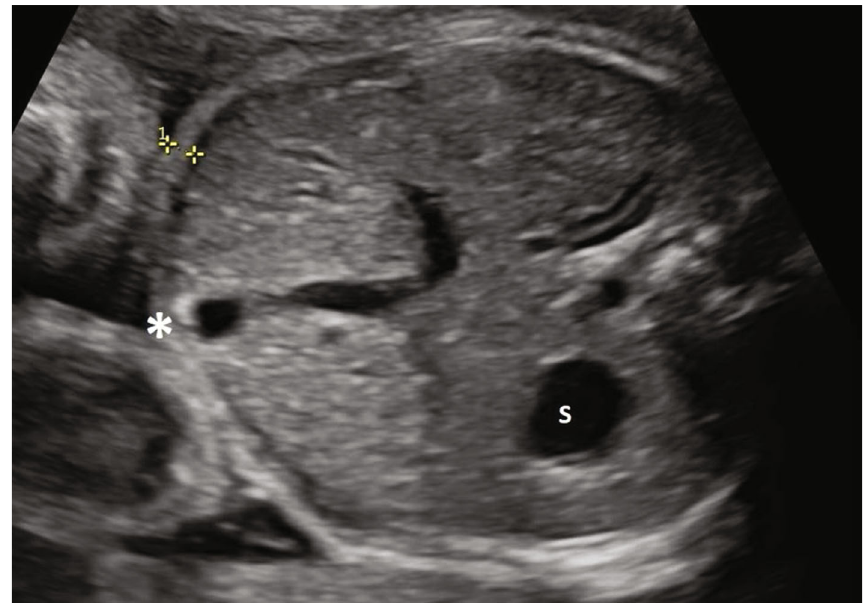
Figure 1: Anterior abdominal wall thickness measurement (calipers) as obtained from the standard abdominal circumference view. S =stomach bubble; ∗ area of cord insertion near origin of portal umbilical vein